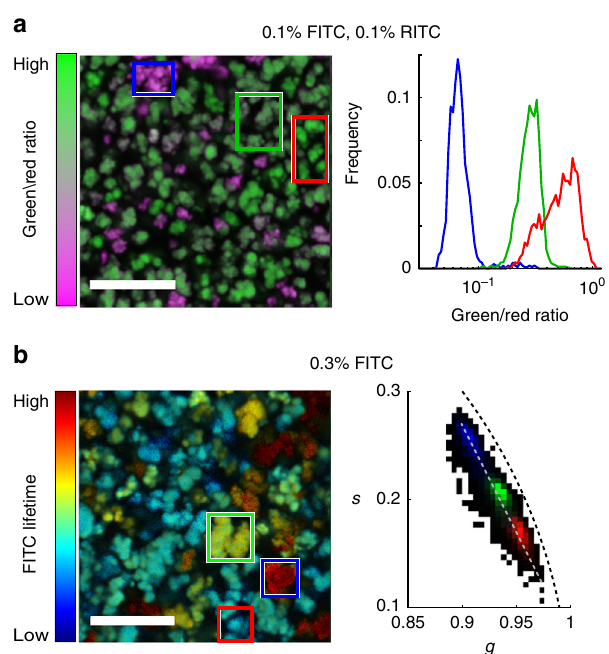
Fig. 3 Fluorescence data for individual UiO-67 particles. a An image (left) and histogram (right) showing the ratio of FITC to RITC fl uorescence of a UiO-67 sample with 0.1% FITC and 0.1% RITC linker input fraction. The three curves represent the regions selected with the coloured rectangles in the image. b A phasor FLIM image (left) and histogram (right) of the UiO- 67 sample with 0.3% FITC linker input fraction. The 2D colored histograms correspond to the regions highlighted with the colored rectangles in the image. The color coding of the images is based on the pixel phasor position along the gray line in the phasor histogram. The scale bar in the images